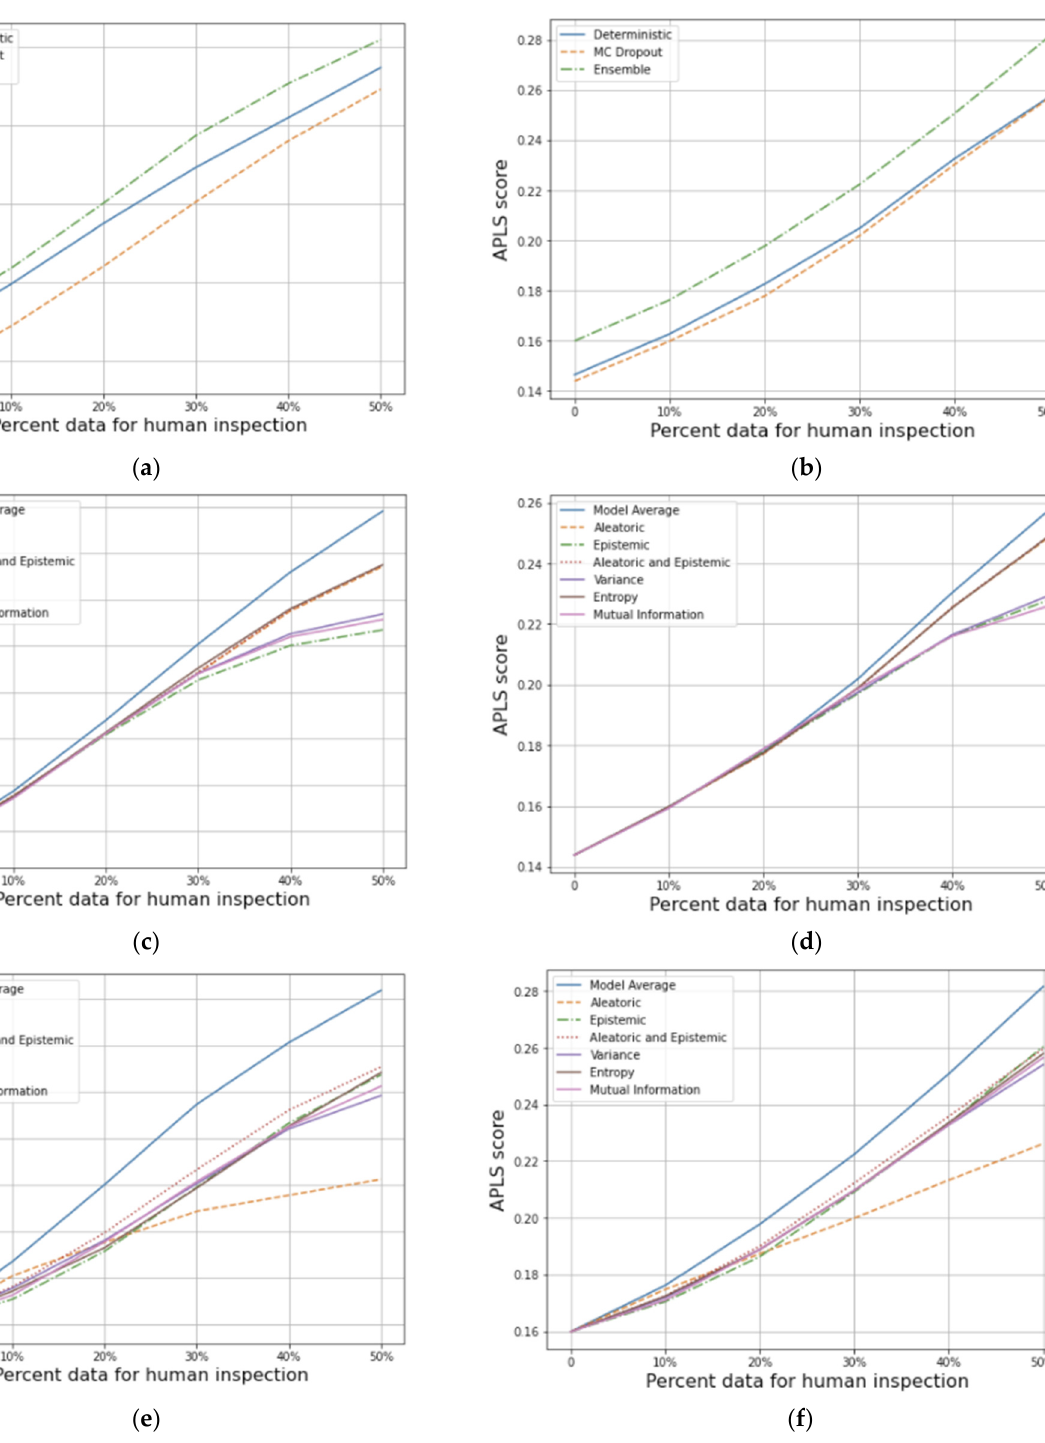
Figure 11. IoU ( a ) and APLS scores ( b ) over data retention rates for OOD data, and performance comparison of aleatoric, epistemic, variance, entropy and mutual information measurements with MCD ( c,d ) and DE ( e,f ) model averages on OOD data. As with ID data, DE’s perform best, and model averages perform better than other measurements at all levels of data retention.